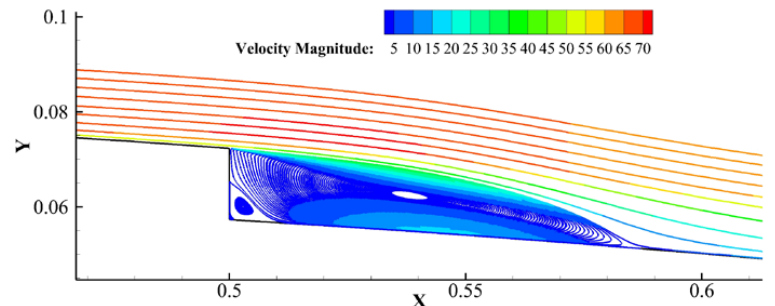
Figure 8. Streamlines showing the separation of the flow at the step edge and the creation of low pressure recirculation zones over the step’s vicinity. The step is located at the mid-chord length on the suction side of a NACA 2412 ( Re = 5.9 × 10 6 and α = 2.5 ◦ )